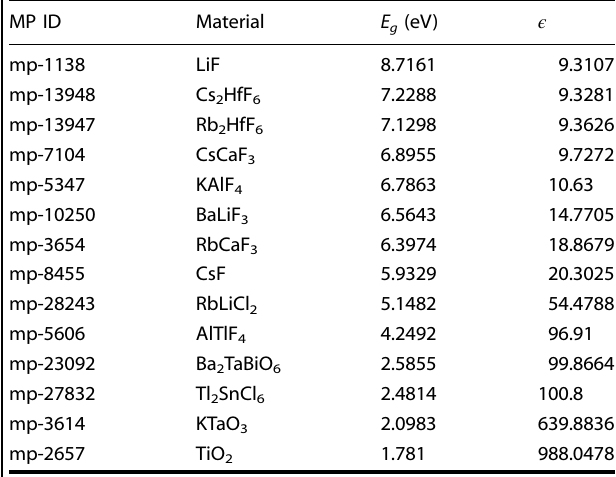
Table 1. The Pareto front of dielectric materials dataset from Materials